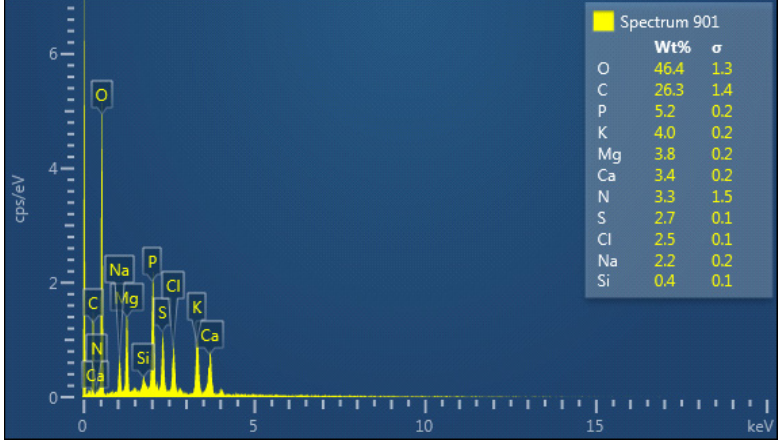
Figure 1. Elemental composition of the bioflocculant from B. subtilis CSM5.